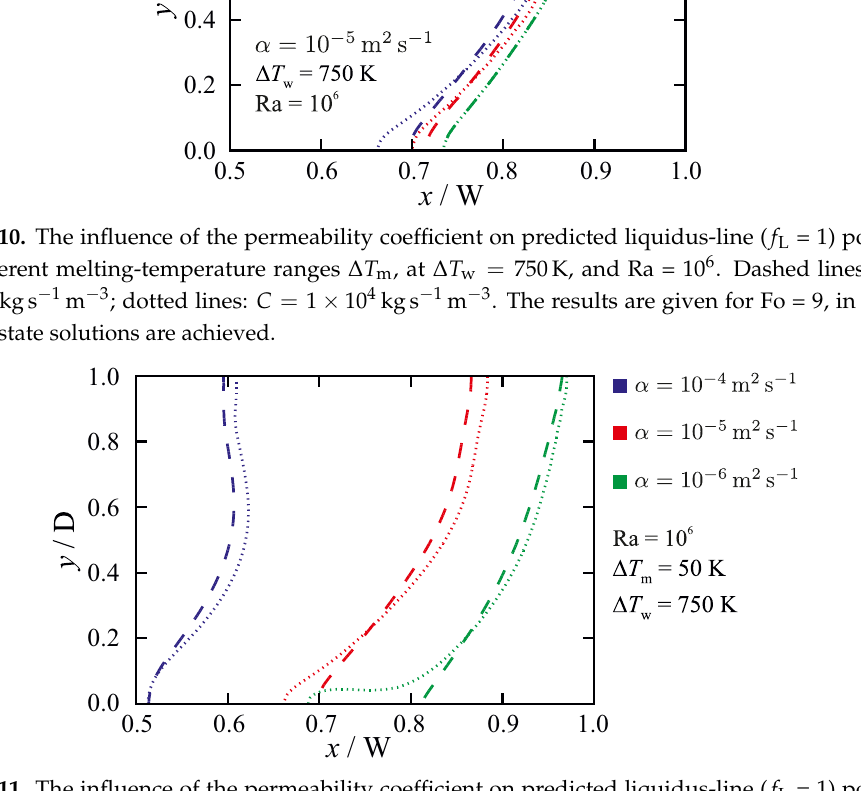
Figure 11. The influence of the permeability coefficient on predicted liquidus-line ( f L = 1) position for different values of thermal diffusivity α , at ∆ T m = 50K, ∆ T w = 750K and Ra = 10 6 . Dashed lines: C = 1 × 10 8 kgs − 1 m − 3 ; dotted lines: C = 1 × 10 4 kgs − 1 m − 3 . The results are given for Fo = 9, in which steady-state solutions are